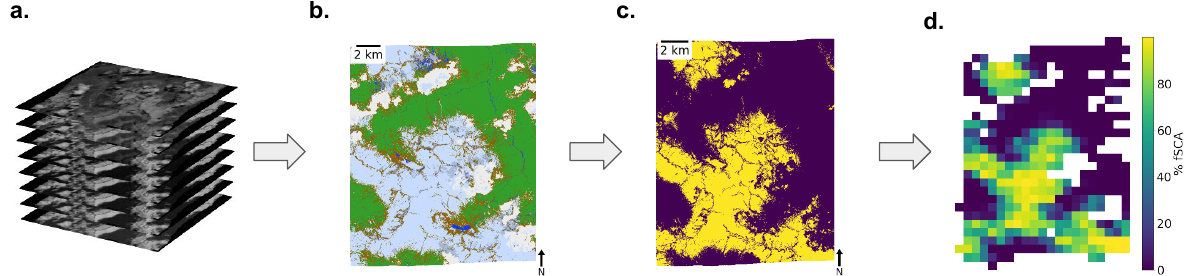
Figure 3. WorldView fractional snow-covered area (WV fSCA) workflow: ( a ) input data stack of WV images, ( b ) model-derived land cover classification, ( c ) binary snow map, and ( d ) WV fSCA map, downsampled to match the coarser resolution fSCA products for